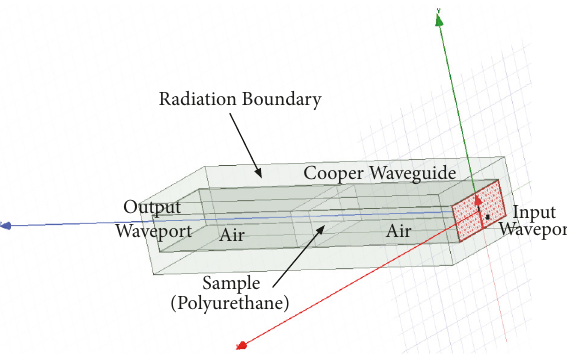
Figure 2: Geometric model for the simulation of the rectangular waveguide with an absorber material sample.